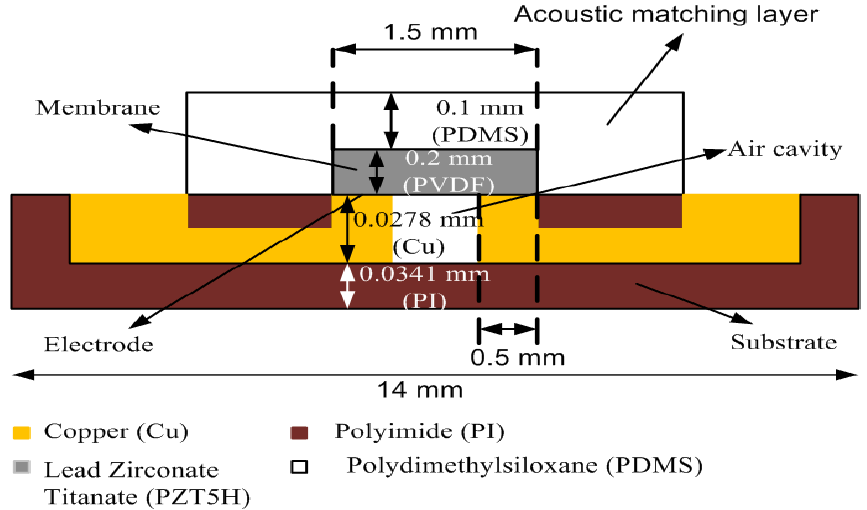
Figure 2. Schematic drawing of the new structure proposed for in-plane polarization.